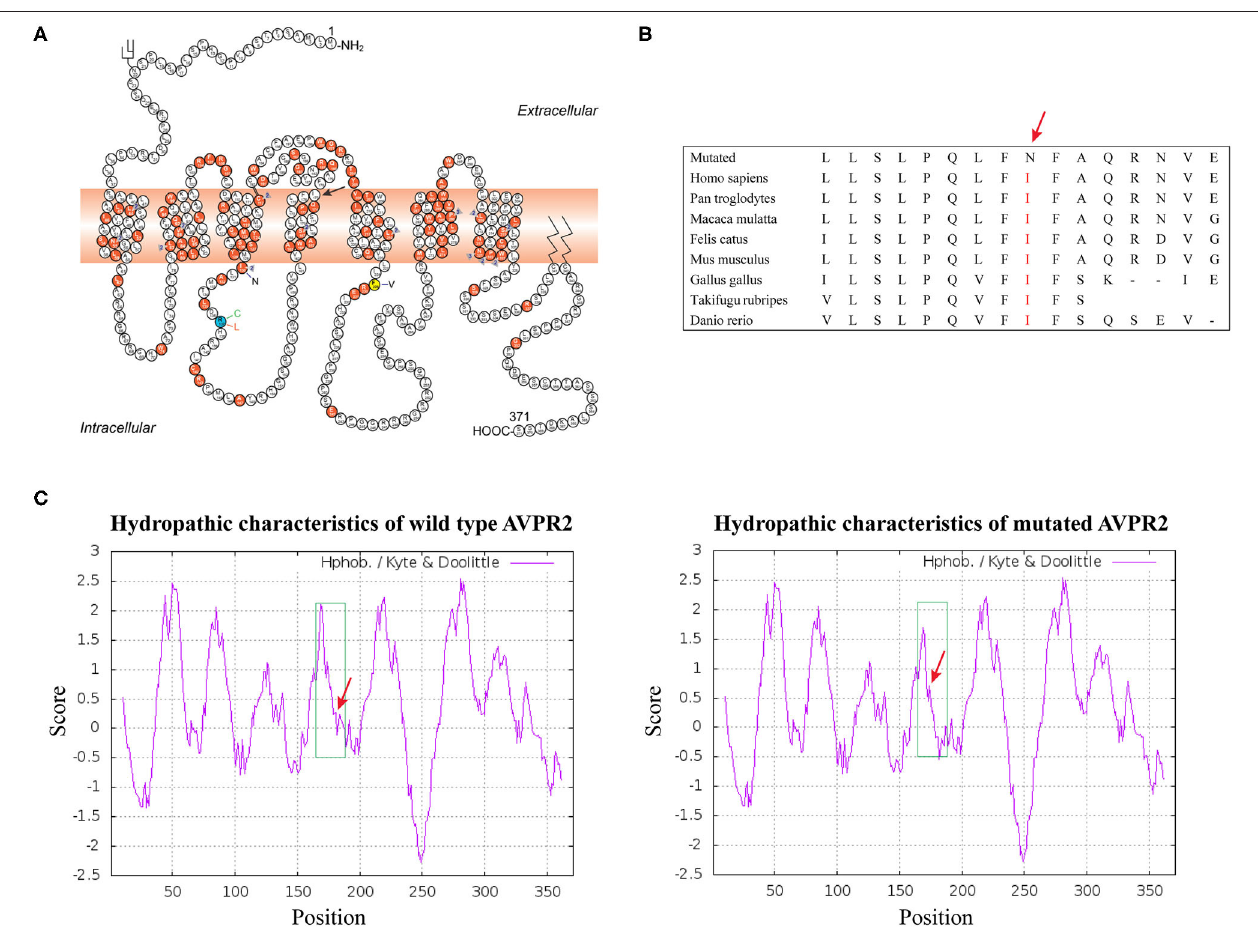
FIGURE 2 | (A) Schematic representation of the AVPR2 [The figure is an excerpt from Bichet et al. (4)]. A solid symbol indicates a codon with a missense or nonsense mutation; a number (within a triangle) indicates a different mutation on the cDNA level affecting the same codon; other types of mutations are not indicated on the figure. Mutation analyzed in this study is shown with arrow. (B) Analysis of the mutation and protein domains of AVPR2 and alignment of multiple AVPR2 protein sequences across species. The affected amino acid I177 is located in the highly conserved amino acid region in different mammals. Red letters show the I177 site. (C) The hydropathic character of the changes in the mutant protein indicated a higher hydrophobicity than that of the